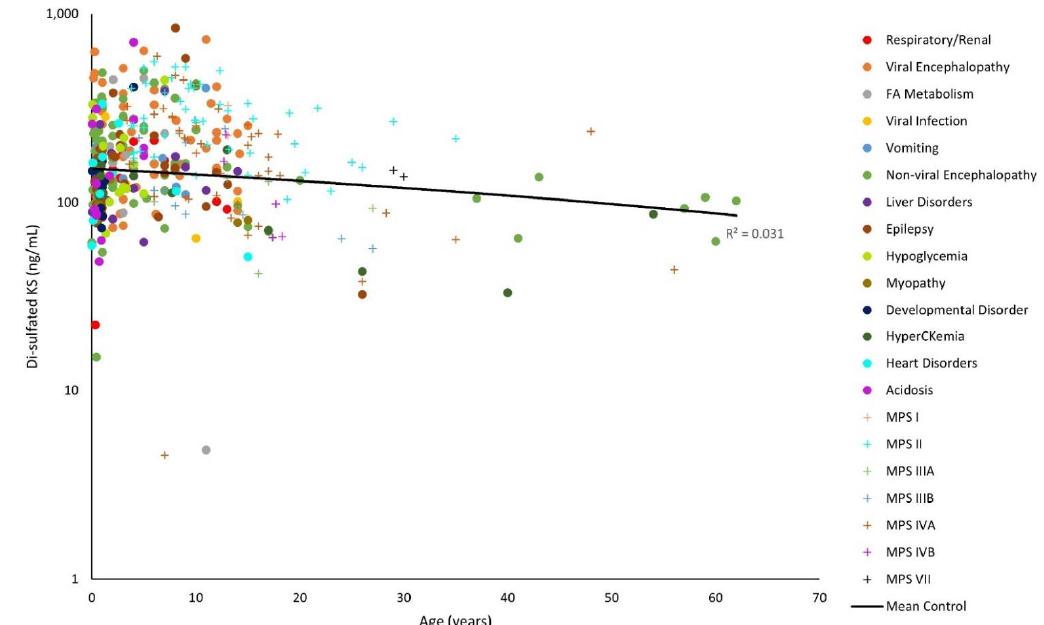
Figure 5. Di-sulfated keratan sulfate (KS) levels by age on a logarithmic scale. The linear trendline of control values is shown as a black line, and glycosaminoglycan (GAG) values of patients with mucopolysaccharidosis (MPS) are shown as plus marks.